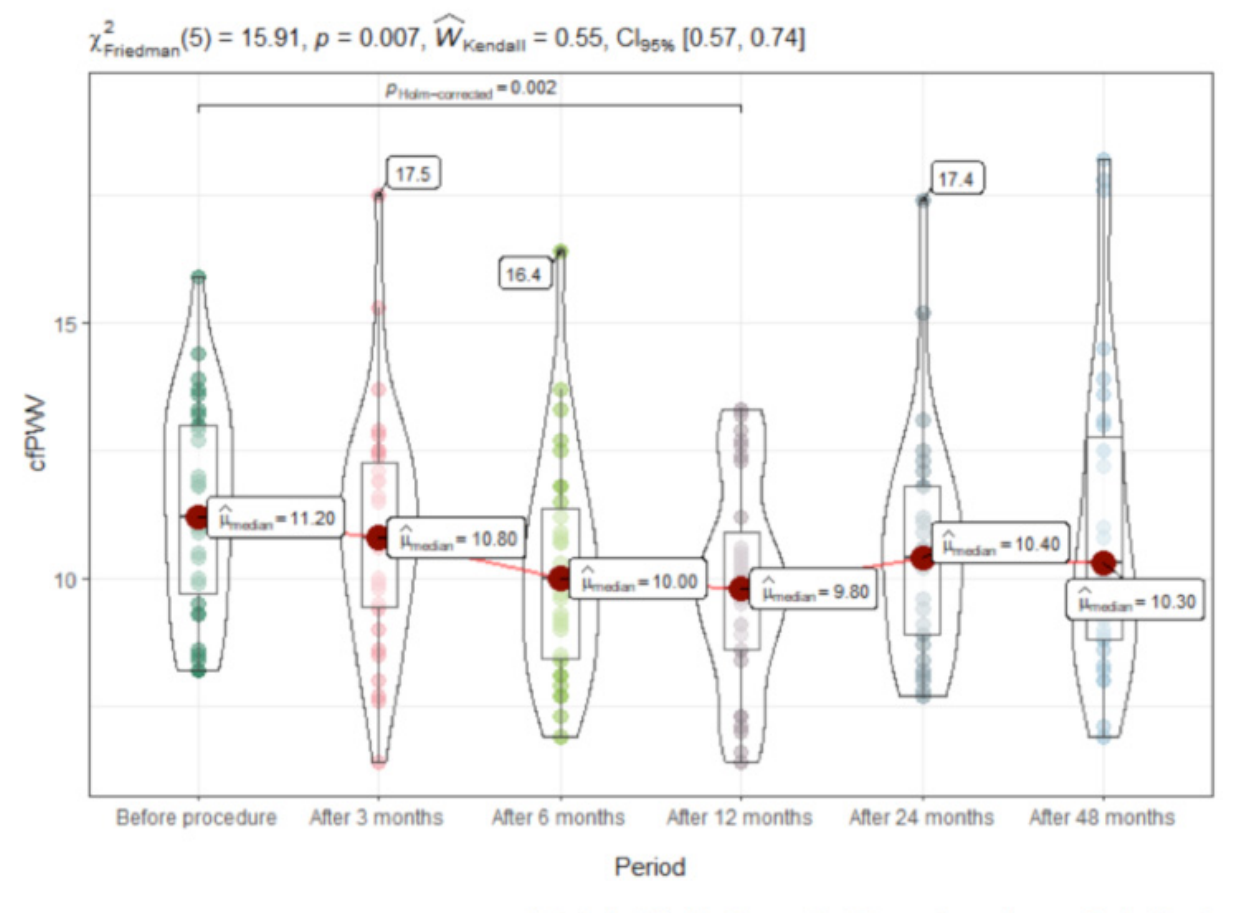
Figure 3. Carotid-femoral pulse wave velocity (CfPWV) dynamics after RDN procedure (m/s).